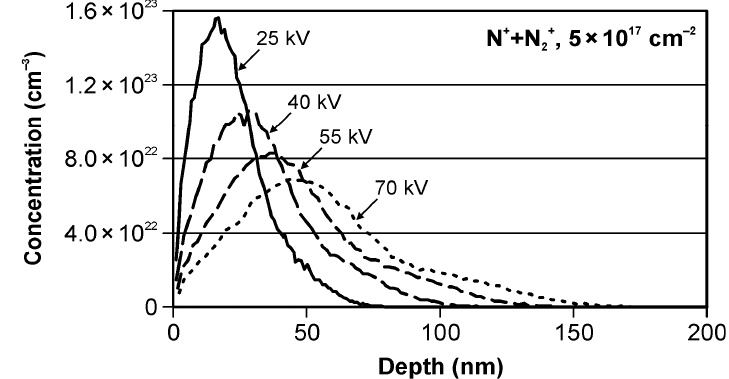
Figure 6. The modelled nitrogen depth profiles in iron.